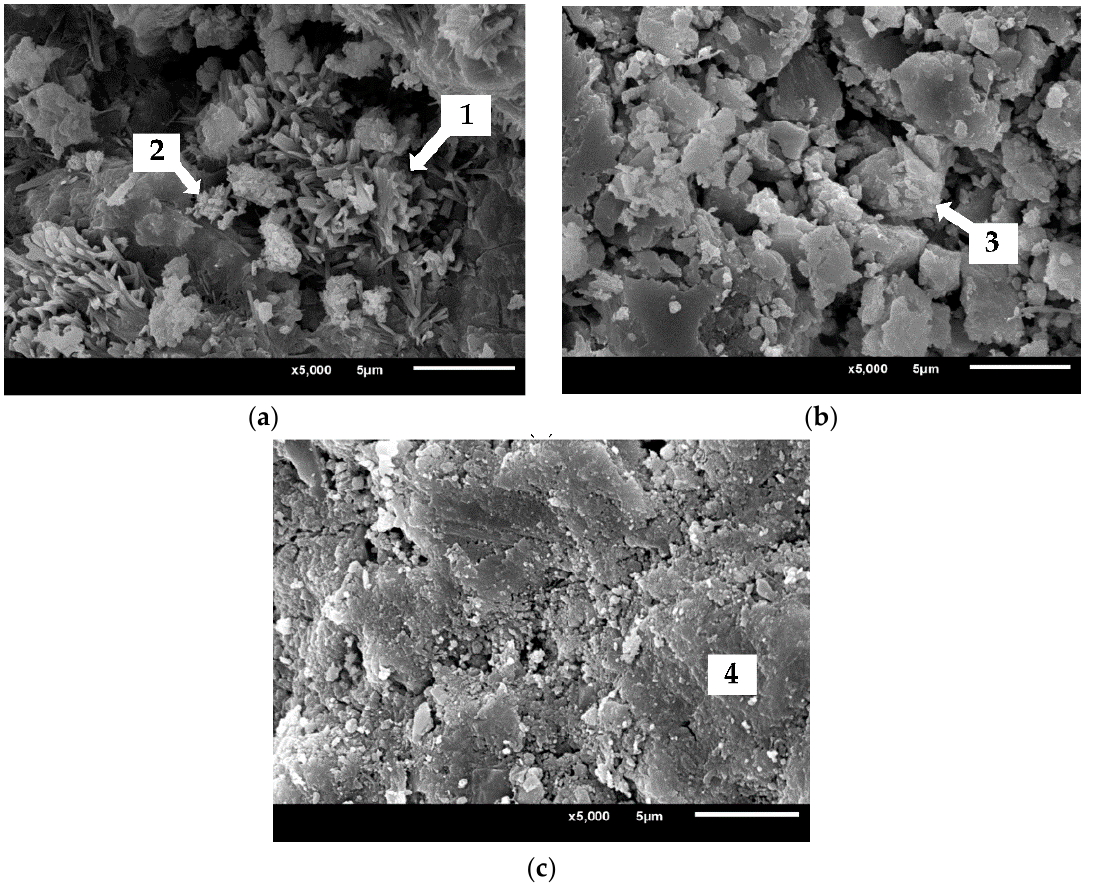
Figure 12. Scanning electron micrographs on the surface of fiber-cement composites: ( a ) non-carbonated; ( b ) 1 h carbonated sample; ( c ) 9 h carbonated sample.